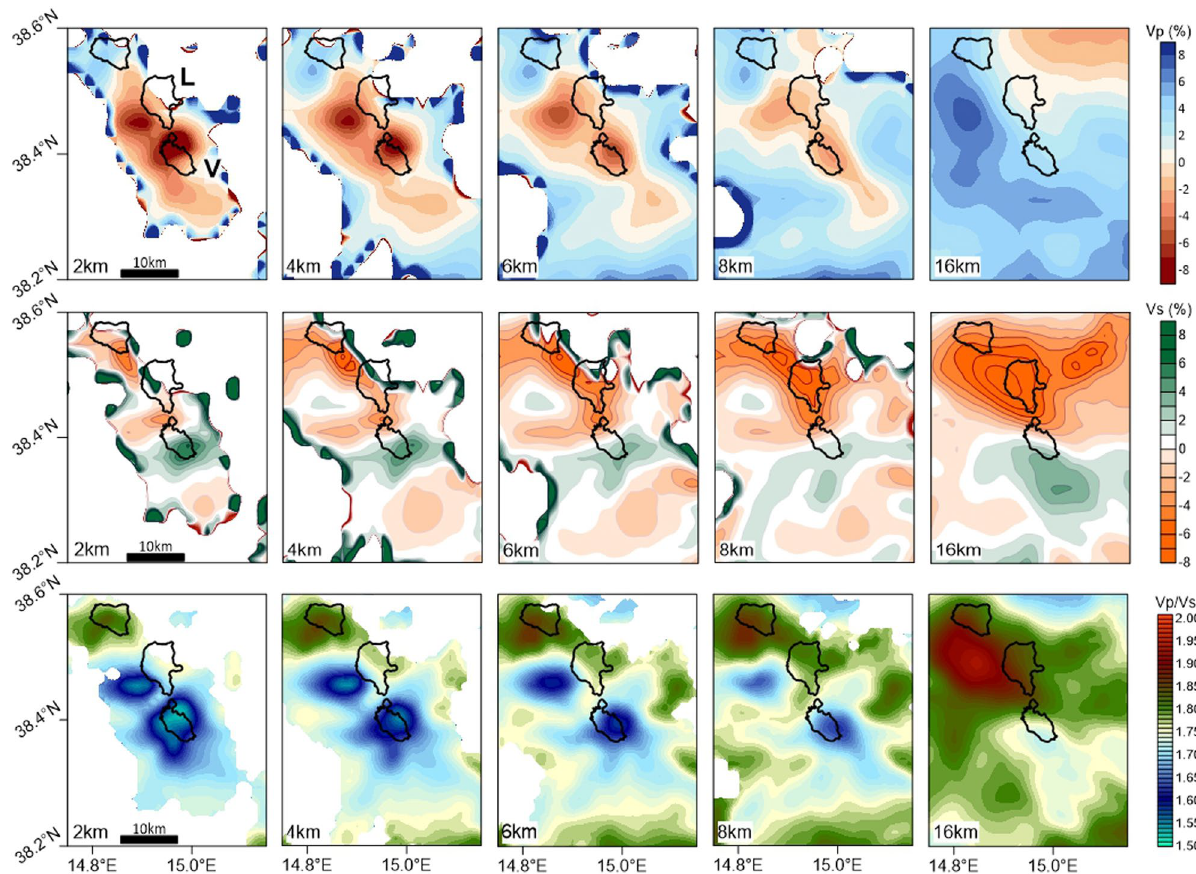
Figure 3. Enlarged view of the tomographic results in the area of the Lipari–Vulcano complex. The results obtained in areas with suitable data coverage are reported in terms of percentage variation of P- and S-wave velocity with respect to the optimal 1D reference model (top and middle) and in terms of Vp/Vs ratio (bottom), respectively. The number in the low-left corner indicates the b.s.l. depth in